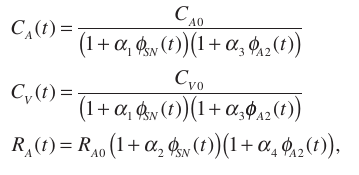
, α , α , and α are con- 1 2 3 4